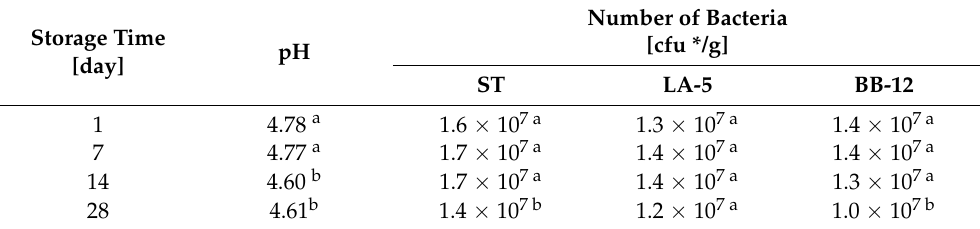
Table 1. Number of bacteria and pH of the milk fat–inulin spread as an effect of storage at 5 ◦ C. Storage Time